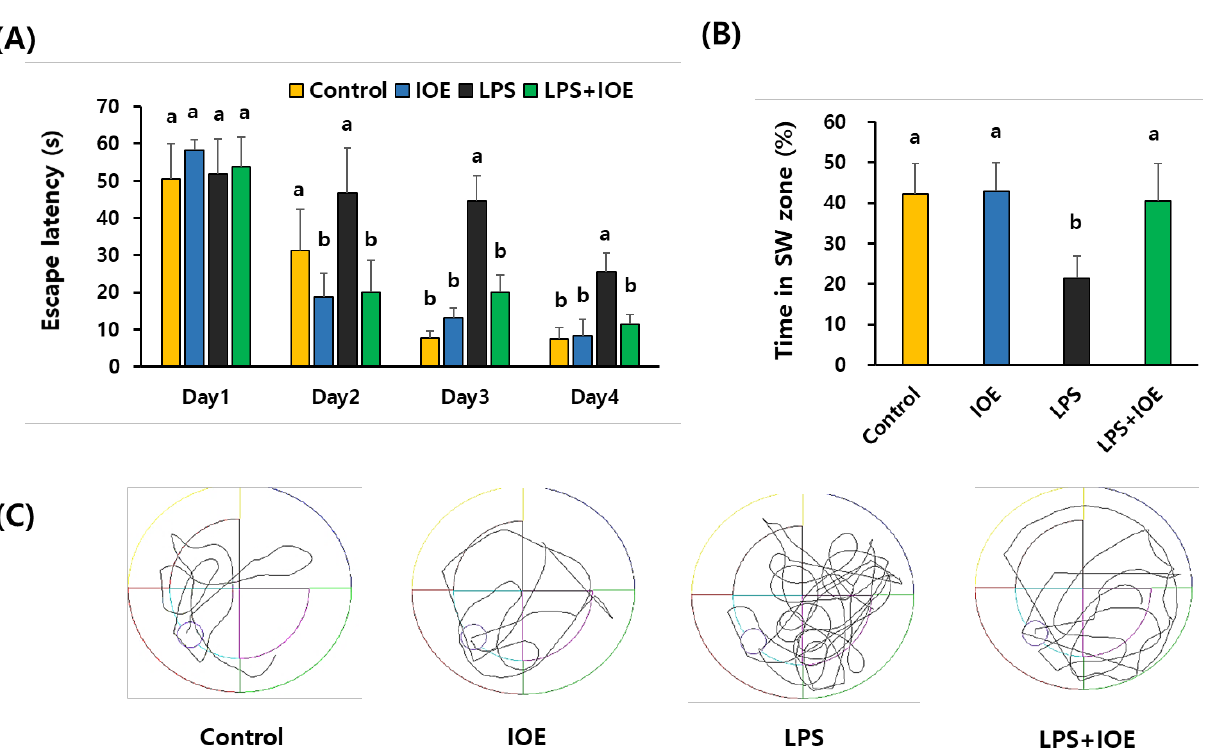
Figure 2. LPS-induced loss of long-term memory in mice was ameliorated by IOE. Long-term memory impairments of each mice group were estimated by using Morris water maze test. Escape latency (s) ( A ), time to stay in W zone at day 5 (%) ( B ), and movement patterns during probe test ( C ) of each mice group was estimated ( n = 7). Data shown are the mean ± SD. Different letters (a,b) indicate the significant differences between groups ( p < 0.05). Each value is assigned as a and b sequentially from the highest value.